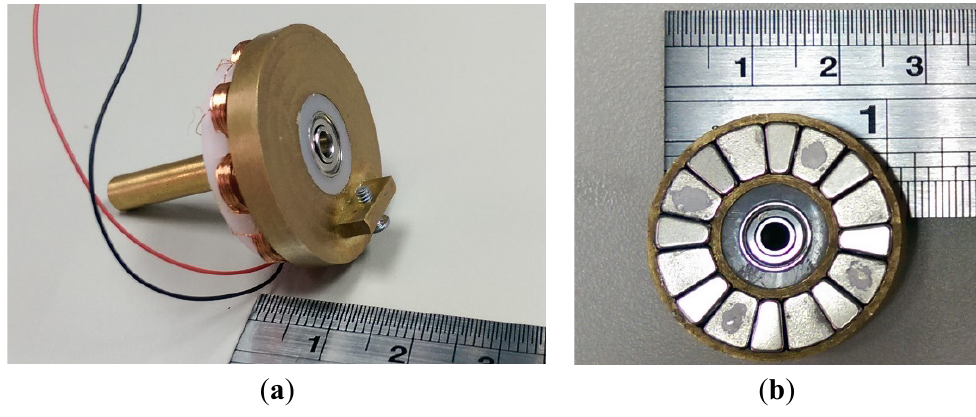
Figure 10. Prototype of the WREH with mass moment of inertia 1.725 × 10 − 6 kg·m 2 . ( a ) The weighted rotor assembled with the coil sets. ( b ) The circular Halbach array magnetic disk of sector angle ratio r m =